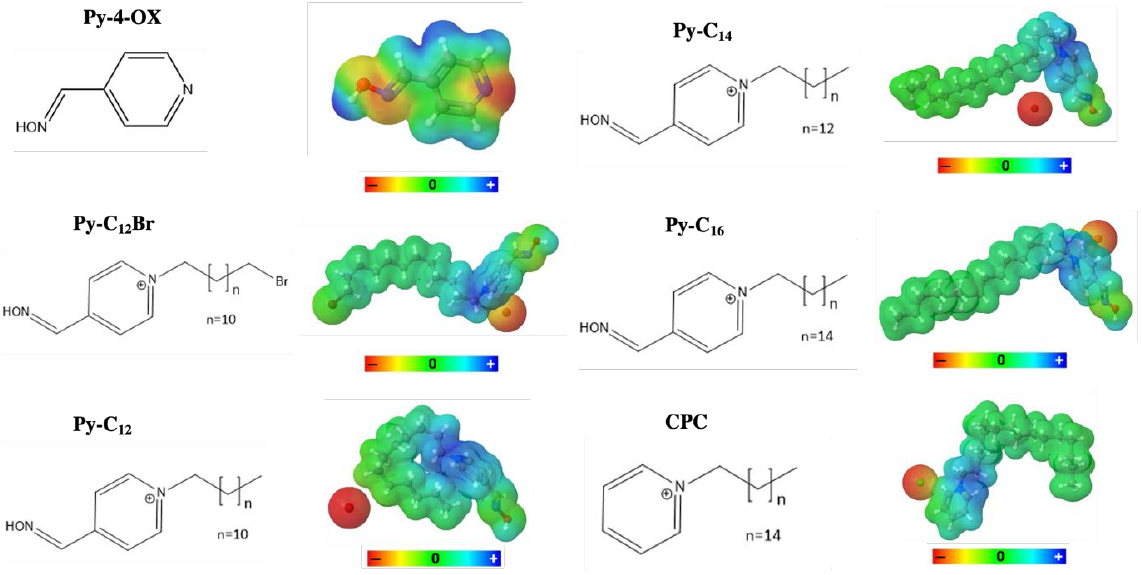
Figure 3. Representative structures of pyridinium-4-aldoxime and its quaternary salts with visualized topological polar surface areas (TPSA).